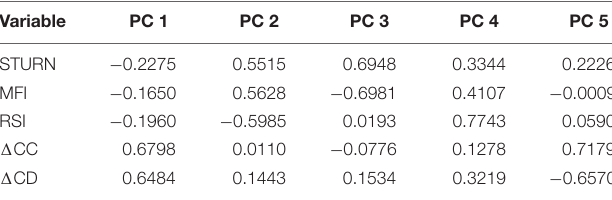
TABLE 8 | The eigen vector loadings (Japan).